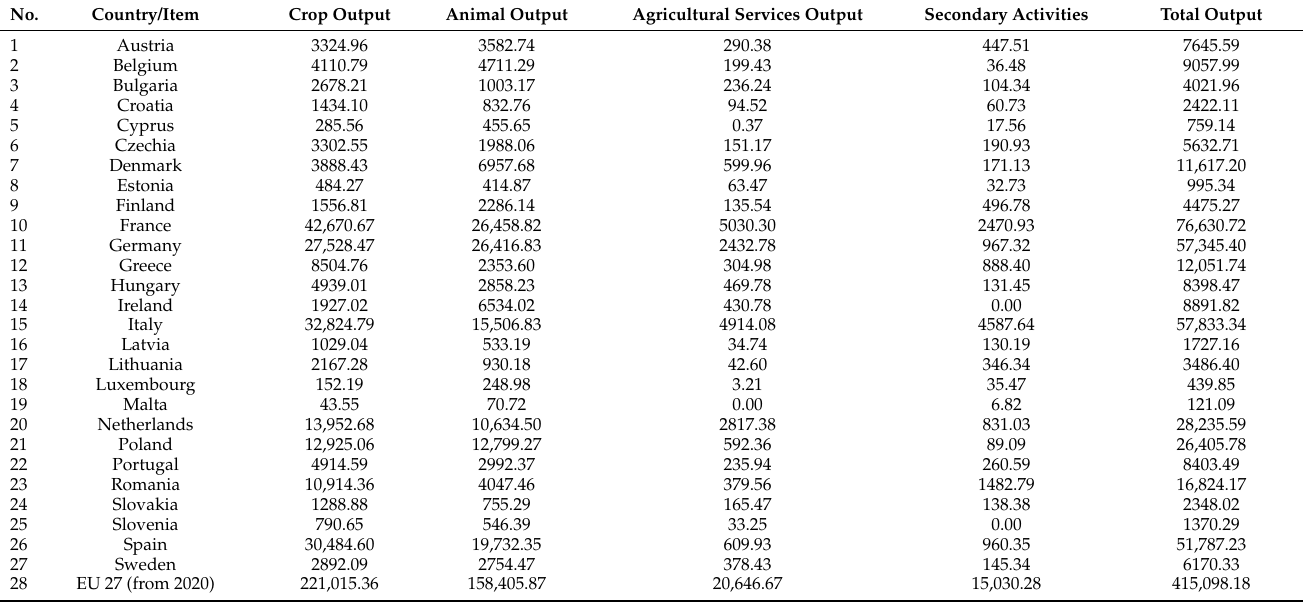
Table 9. Total agricultural output value structure (million